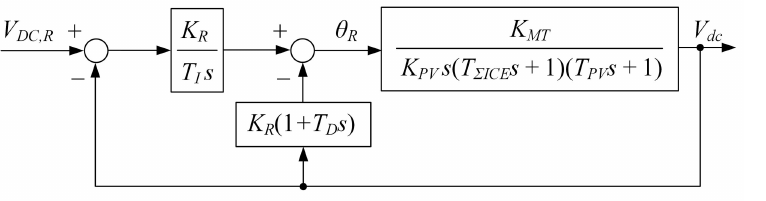
Figure 11. DC bus voltage control